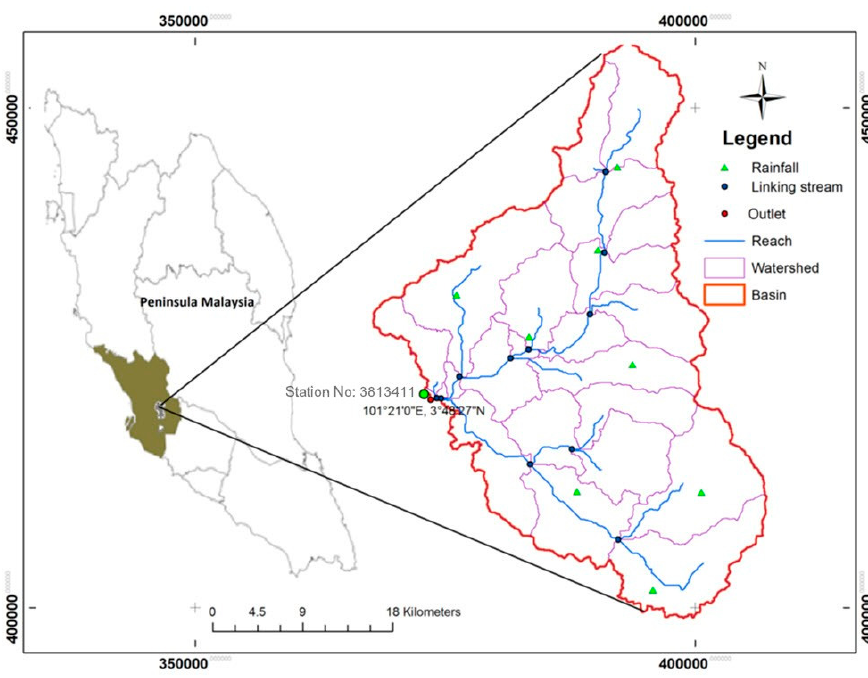
Figure 1. Map of study area: Upper Bernam watershed, Malaysia.